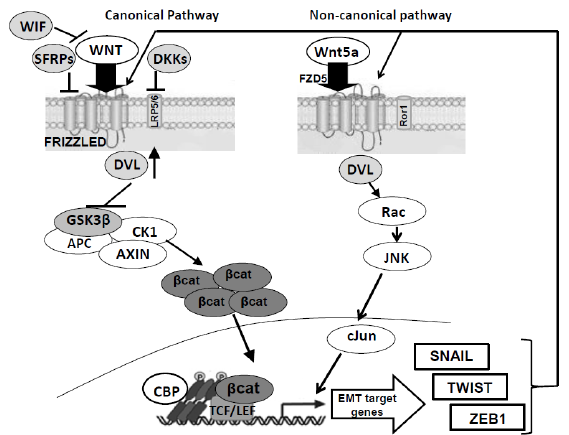
Figure 1. Relationship between epithelial-to-mesenchymal transition (EMT) and the Wnt pathway in glioblastoma-derived stem cells (GSCs). As discussed in the text of the review, a possible relationship seems to exist between the EMT process, which favors the self-renewal, migration and resistance to therapy of cancer stem cells, including GSCs, and the Wnt signals, which, when deranged, as it occurs in GSCs, can activate/cooperate with EMT downstream factors (Snail, Twist, and Zeb1) creating a vicious cycle able to potentiate the activity of upstream factors. The explanation for the abbreviations used are the following: histone acetyltransferase CREB binding protein (CBP); WIF: Wnt inhibitory factor; SFRP: Secreted frizzled-related protein; DKK: Dickkopf; DVL: Dishevelled; GSK3 β : Glycogen synthase kinase 3 β ; CK: Casein kinase; APC: Adenomatous polyposis coli; TCF/LEF: T-cell factor/lymphoid enhancing factor; JNK: Jun N terminal